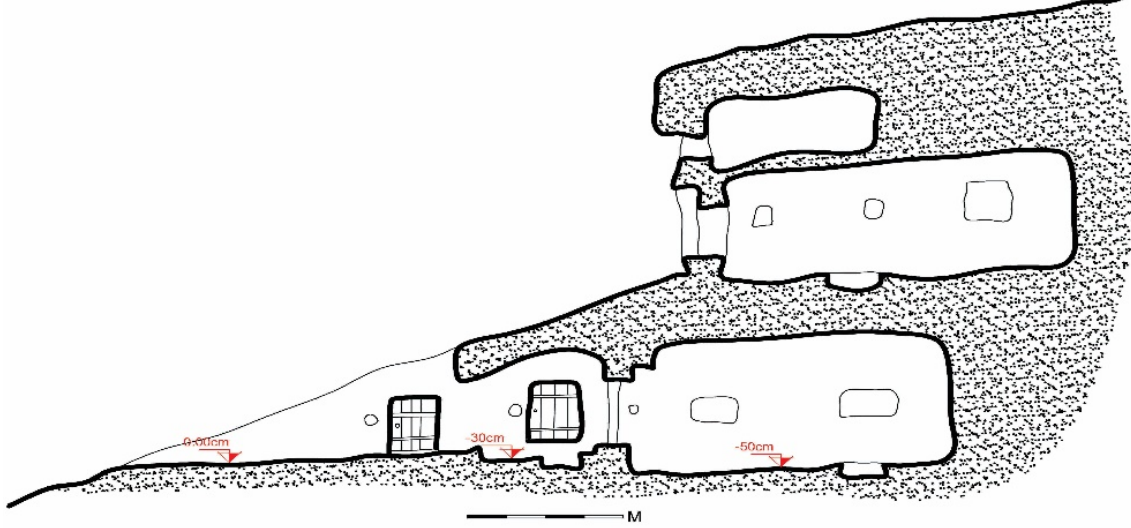
Figure 26. Bottom level of the rooms are lower than that of the entrance trench.